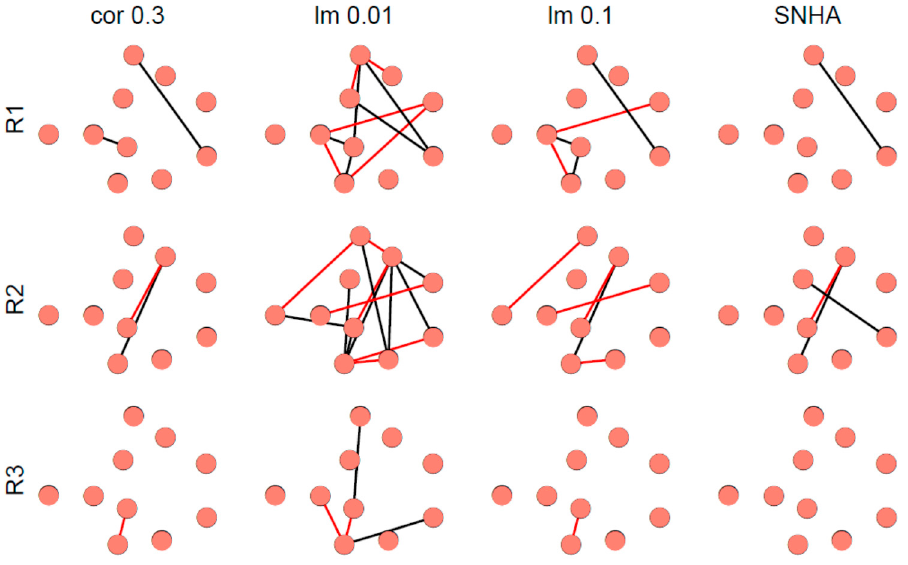
Figure 8. Networks derived from three representative, normally distributed, random generated data sets (R1 to R3) from 33 virtual Olympic decathletes with zero correlations between the variables. Networks were created as described in Figure 7.